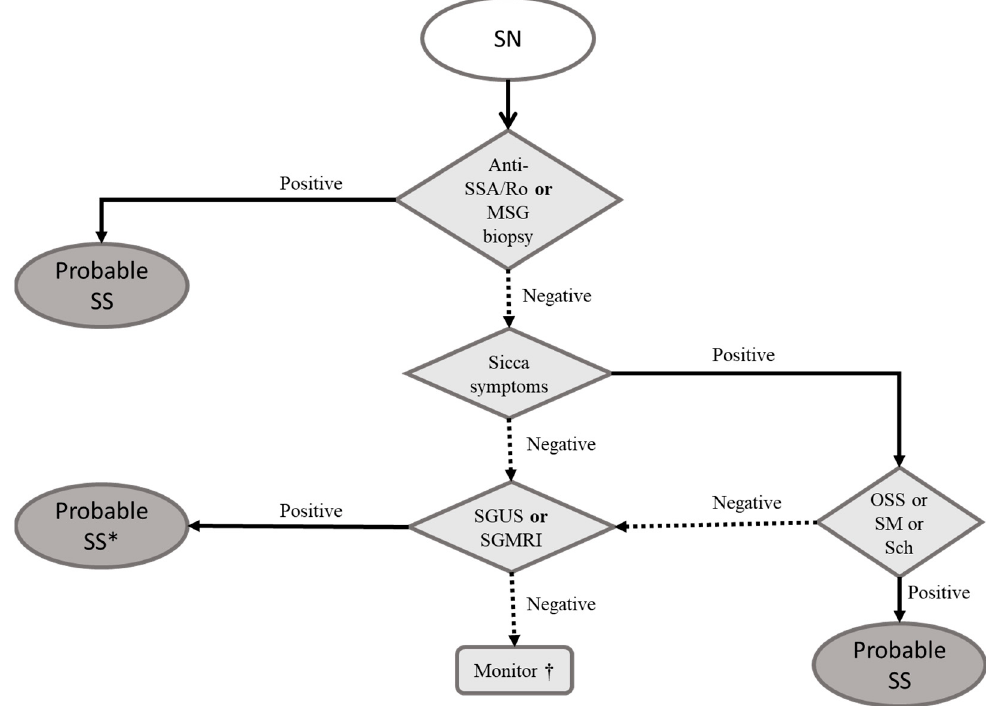
Figure 3. Proposed approach for patients with sensory neuronopathy. Notes: Anti-SSA/Ro is the main autoantibody related to Sjögren’s syndrome and part of the contemporary diagnostic criteria. Sicca symptoms refer to the complaints related to dryness of the mouth, eyes, skin, and genital and